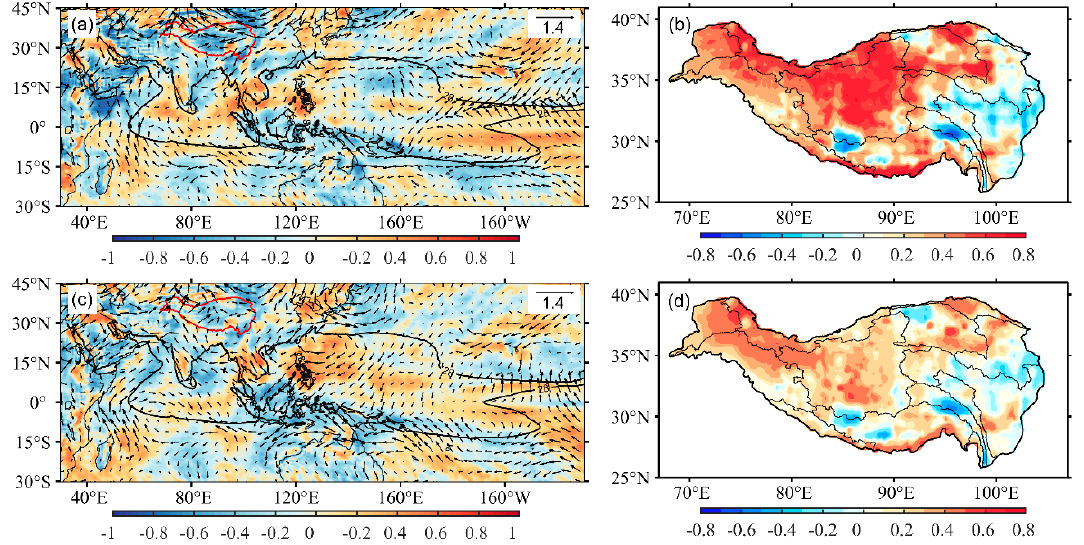
Figure 9. The linear regression pattern of the summer water vapor transport (the arrows represent the water vapor flux, and the shaded areas represent the divergence) against the ( a ) the WPI-slhf from 1979 to 2018 and ( c ) WPI-SST from 1982 to 2018, ( b ) is similar to ( a ), and ( d ) is similar to ( c ), but for summer precipitation in the TP.